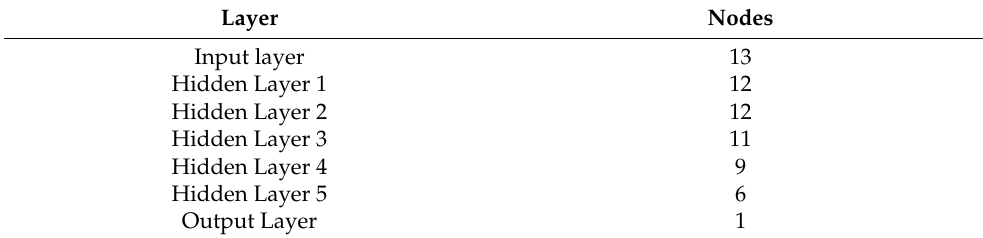
Table 2. Number of nodes for each layer excluding BBE data ( − BBE).